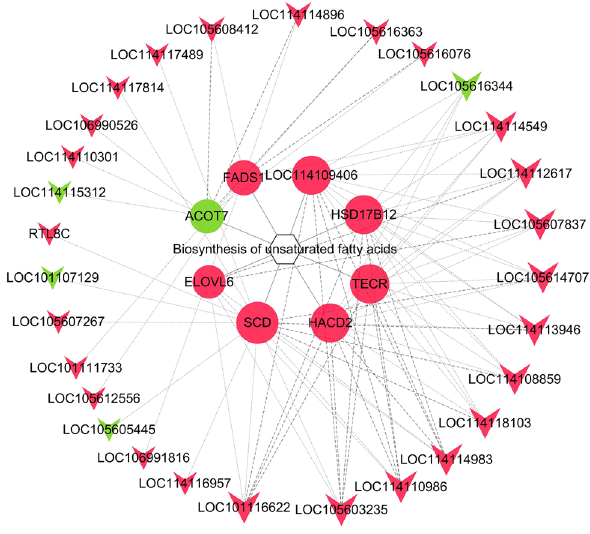
Figure 6. lncRNA biosynthesis of unsaturated fatty acids network. Inverted triangles, circles and hexagons represent lncRNAs, genes and pathways, respectively. Red represents up-regulation, and green represents down- regulation. The edge represents the interaction strength.